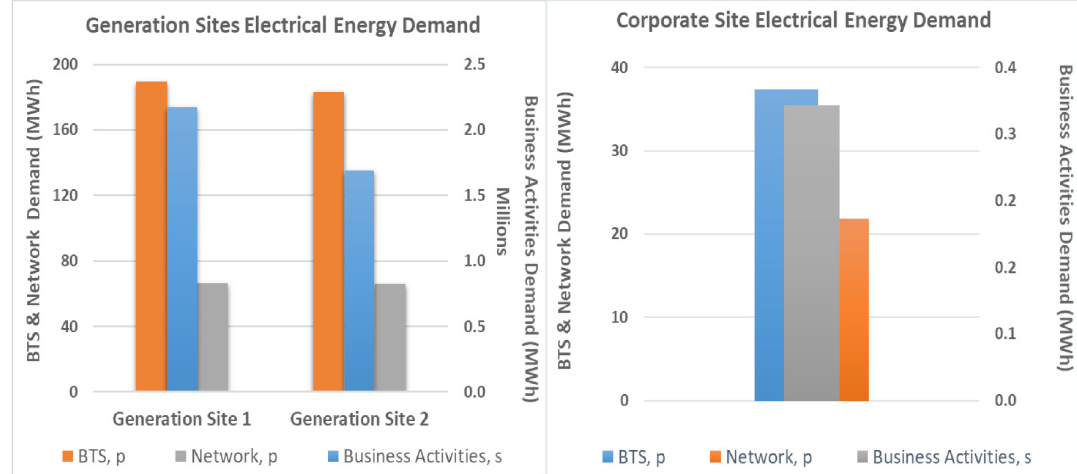
Figure 4. (a) Generation site electrical energy demand profile. (b) Corporate site electrical energy demand profile